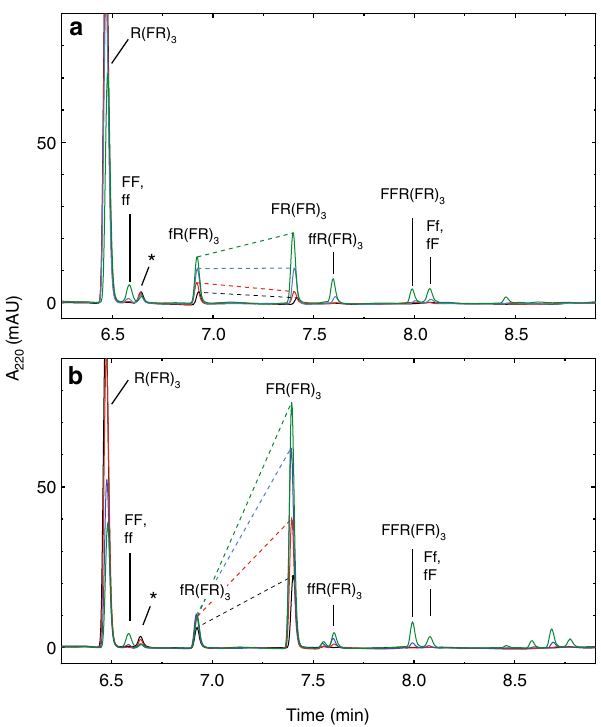
Fig. 2 Stereospeci fi city of the single additions to R(FR) 3 /(FE) 4 amyloid. Reverse-phase HPLC chromatograms of the addition reactions of DL- phenylalanine with soluble substrate R(FR) 3 ( a ) and amyloid R(FR) 3 /(FE) 4 ( b ). The R(FR) 3 concentration was 100 μ M, the (FE) 4 concentration was 130 μ M and amino acids were at 25 μ M (black), 50 μ M (red), 100 μ M (blue), 200 μ M (green) of each enantiomer. The D-amino acid addition products are denoted with lower case letters. The single addiction product diastereomers are connected with a dashed line to illustrate differences in the yield of the products at different concentration of amino acid. The * indicates the C-terminal deamidated substrate that remained after puri fi cation. For a qualitative comparison of the speci fi city of addition of other amino acids, see Supplementary Fig. 3 and Supplementary Table 2